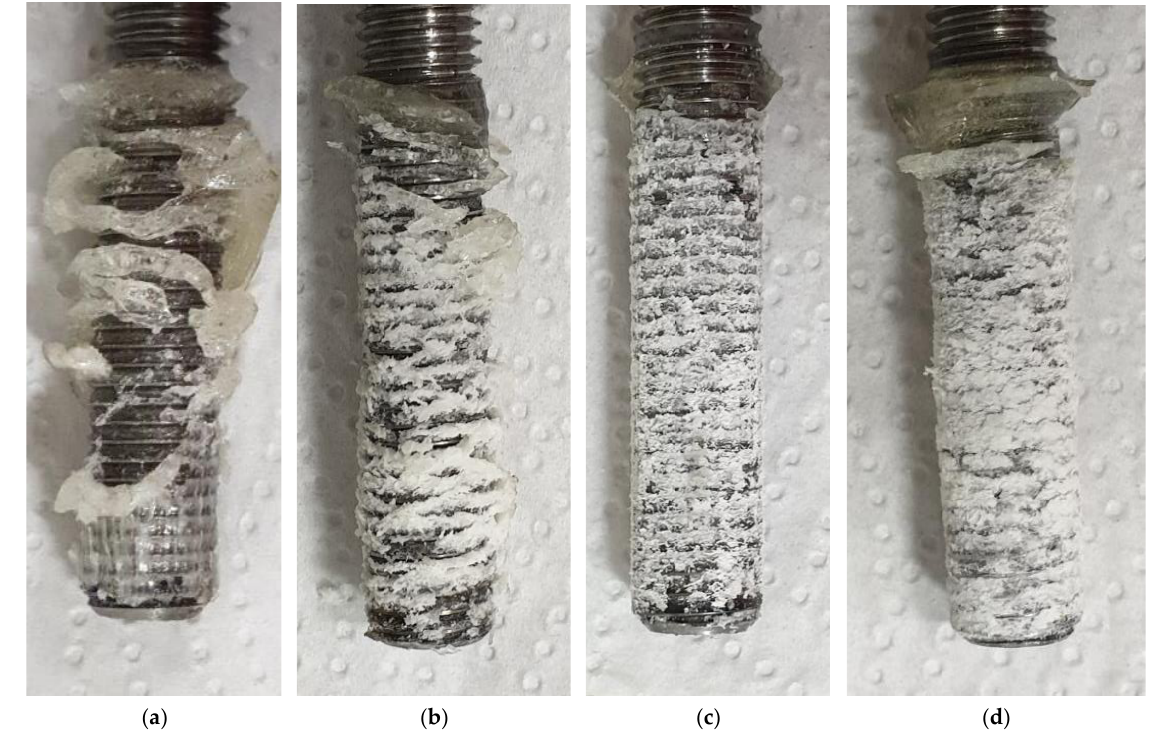
Materials 2021 , 14 , x FOR PEER REVIEW Figure 16. Failure of 531-AN2609 at 5 °C, curing time: ( a ) 15 h; ( b ) 24 h; ( c ) 48 h; ( d ) 72 h. Figure 16. Failure of 531-AN2609 at 5 ◦ C, curing time: ( a ) 15 h; ( b ) 24 h; ( c ) 48 h; ( d ) 72 h.